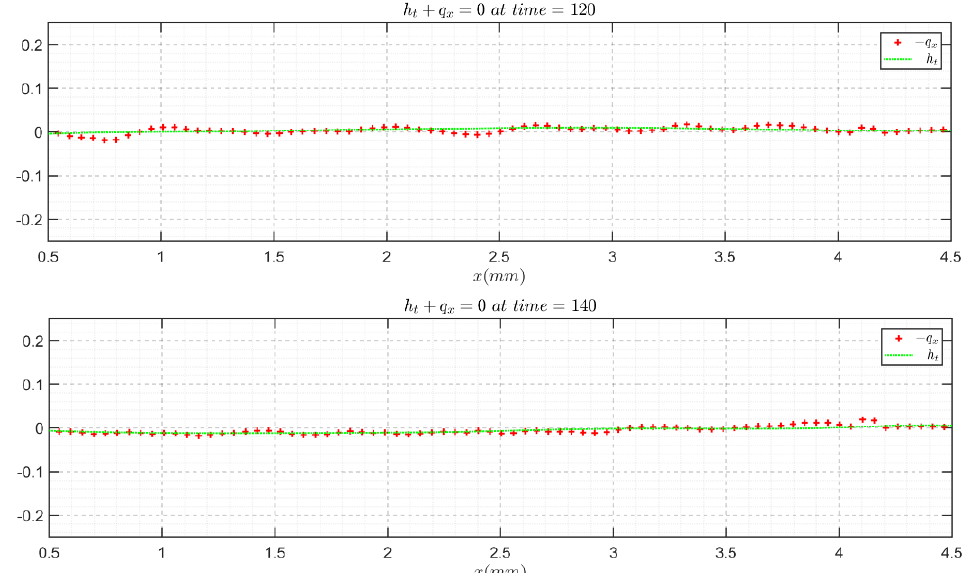
Figure 10. Continuity equation validation with the instantaneous velocity field and film topology for the Re = 7.43, f = 5 Hz glycerol film flow case.